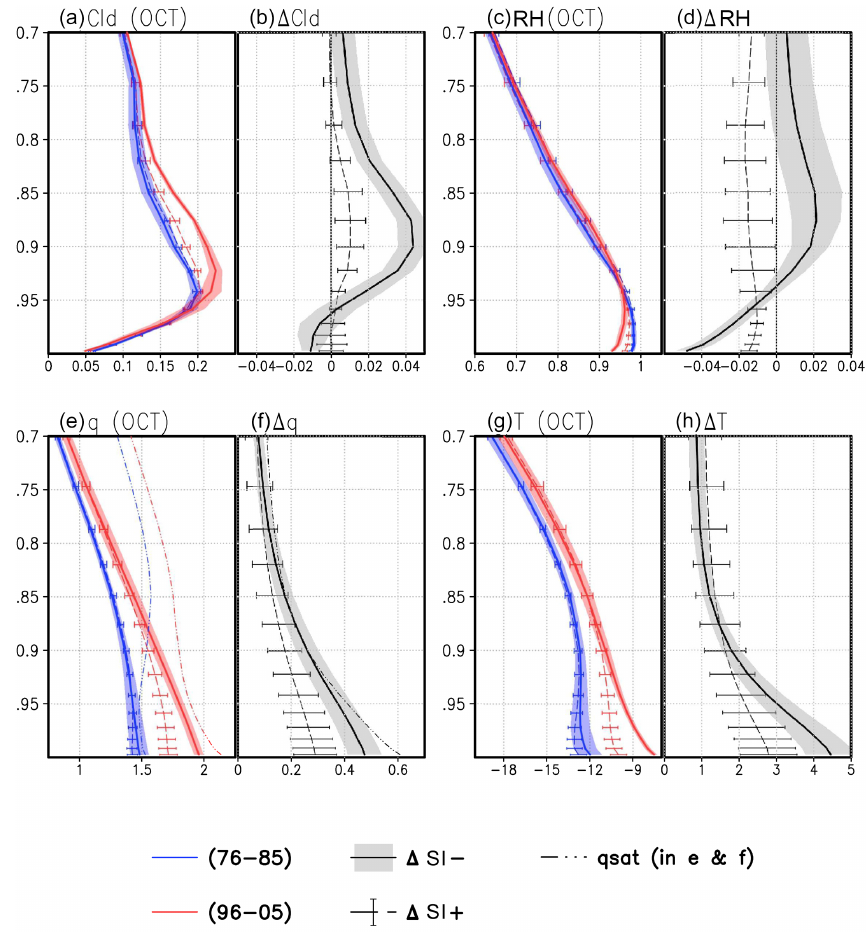
Figure 8. Vertical profiles of the average (a) cloud fraction, (c) relative humidity (RH), (e) specific humidity, and (g) air temperature in October in the MIROC5 simulations for the periods 1976–1985 (blue) and 1996–2005 (red). The solid (broken) line represents the (cid:49) SI − ( (cid:49) SI + ) case. See the text for the definitions of the (cid:49) SI − and (cid:49) SI + cases. Vertical profiles of the differences between average (b) cloud fraction, (d) relative humidity, (f) specific humidity, and (h) air temperature in October in the MIROC5 simulations for the periods 1976– 1985 and 1991–2005. The solid (broken) line represents the (cid:49) SI − ( (cid:49) SI + ) case. The dot–dot–dash lines in (e) and (f) indicate the saturated specific humidity. The units of air temperature and specific humidity are K and gkg − 1 , respectively. Shading and error bars indicate the standard deviations for the ensemble members in the (cid:49) SI − and (cid:49) SI + cases,